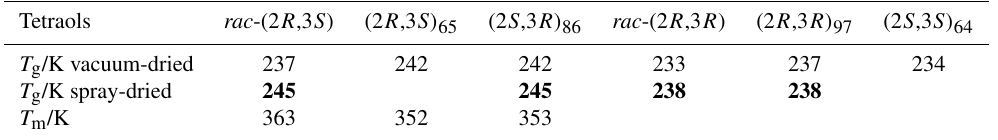
Table 1. Glass transition temperatures T g of vacuum-dried and spray-dried racemic and enantiomerically enriched tetraols and melting temperatures T m for crystallized samples. The enantiomeric excess is given as subscript. The spray-dried samples were handled and sealed in a dry glove box before DSC measurement and, therefore, provide the most accurate T g values, which is why they are given in boldface. Tetraols rac -(2 R ,3